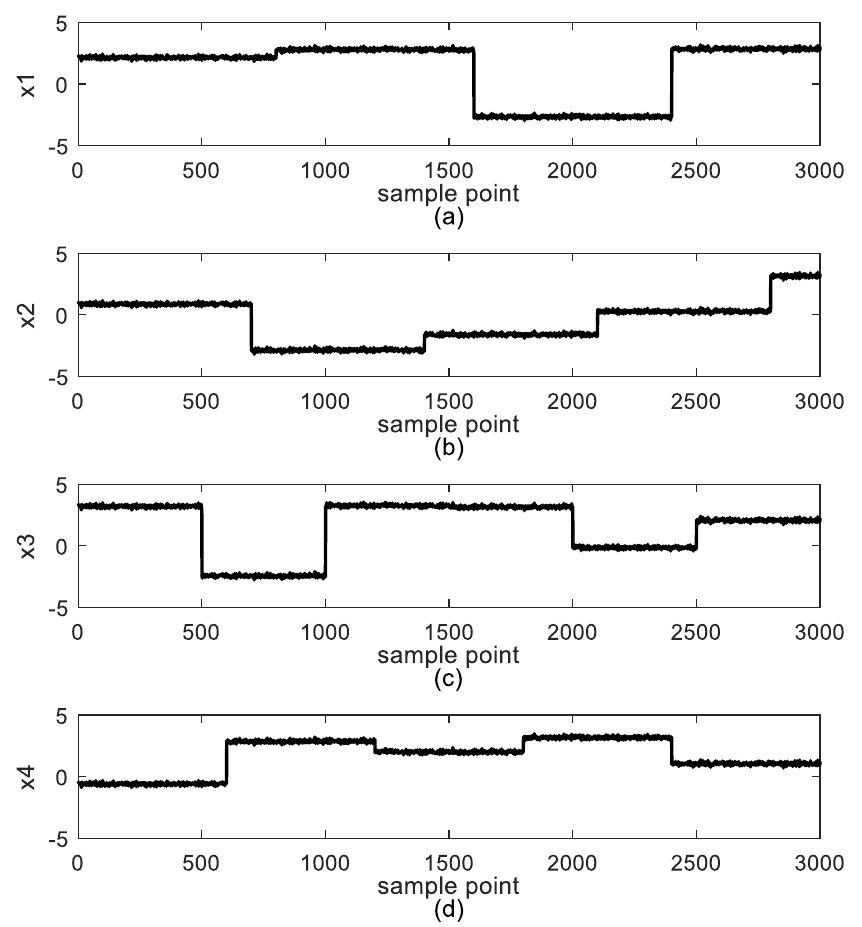
Figure 10. Output data set for polyethylene reaction: ( a ) y 1 —production; ( b ) y 2 —slurry polymer; ( c ) y 3 —catalyst efficiency.